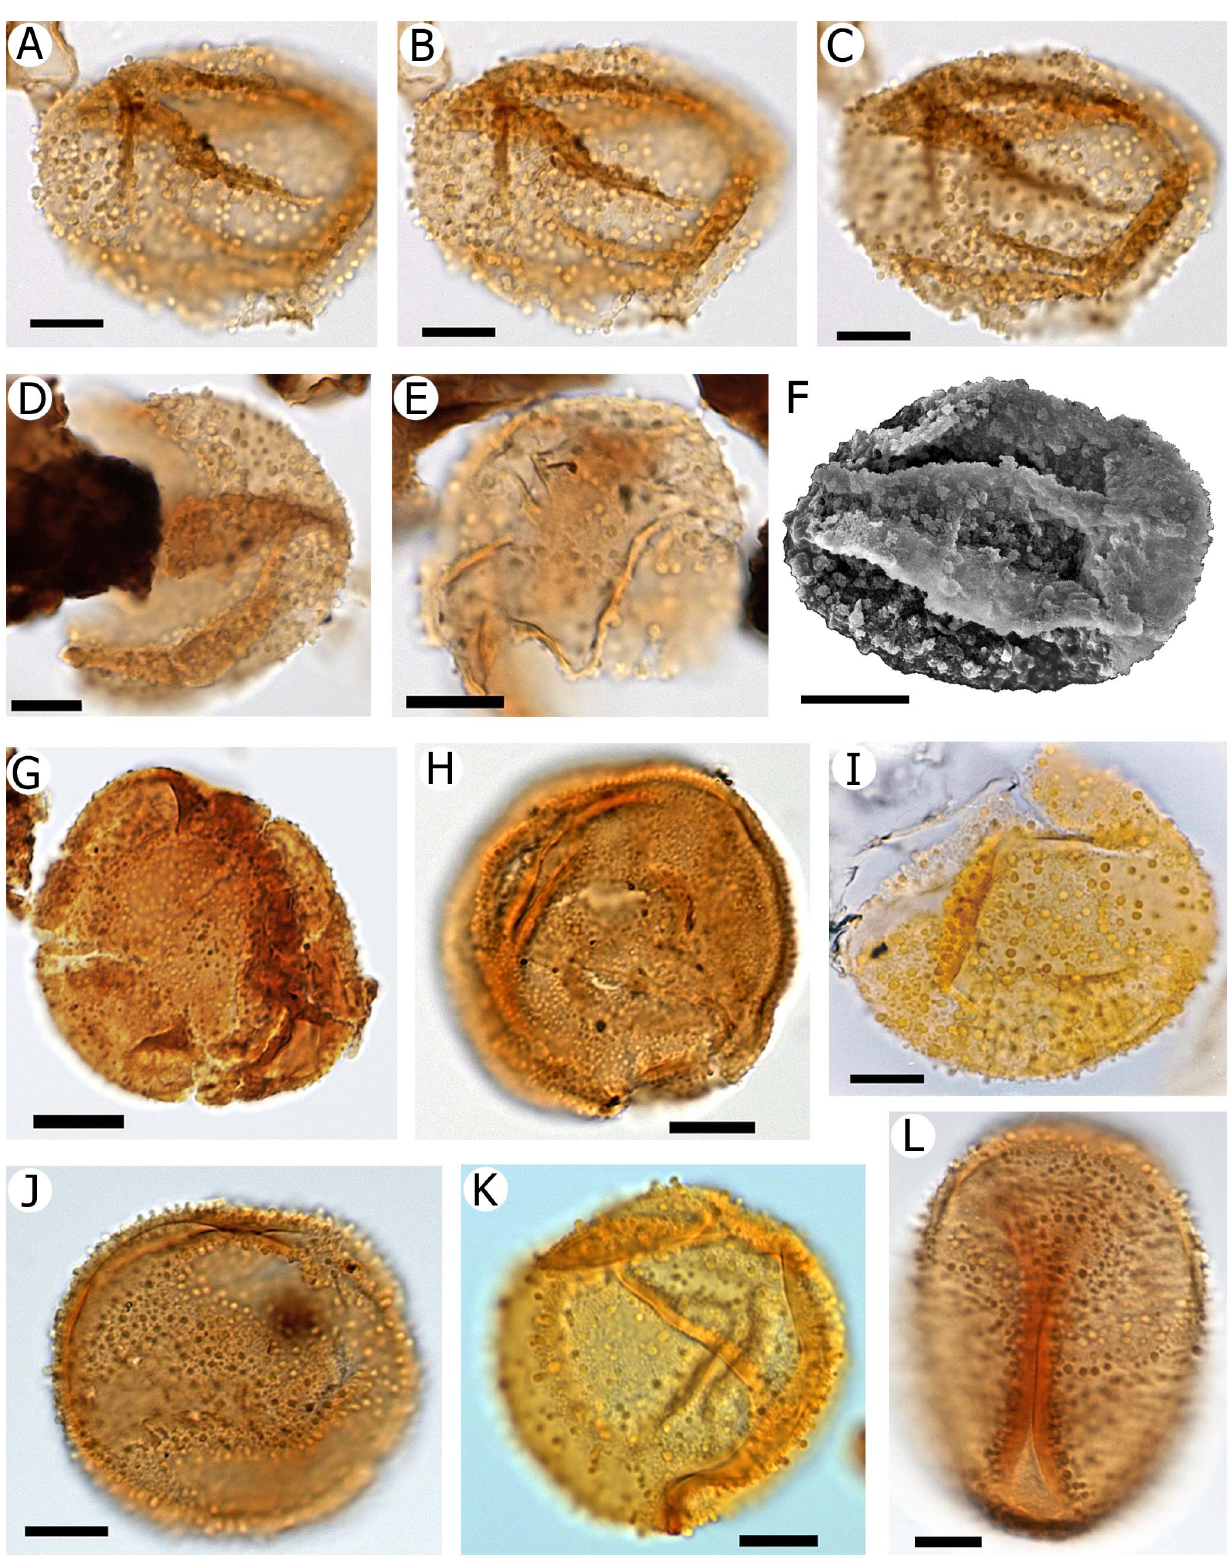
Figure 2. Microscope images of Dilwynites spp. (A–K) and Agathis pollen (L). A–F, Dilwynites sp. cf. D. tuberculatus from the Rı´o Zeballos locality, Ligorio Ma´rquez Formation, Santa Cruz, Argentina. A–C, single grain, showing details including clavae/gemmae at three focal planes. D–F, other specimens (F is a scanning electron microscope image). G, H, Dilwynites granulatus from Australia showing granulate ornamentation. G, Ti-tree Basin, Northern Territory (early Eocene). H, Frome Embayment, South Australia (Miocene). I–K, Dilwynites tuberculatus from Australia, showing